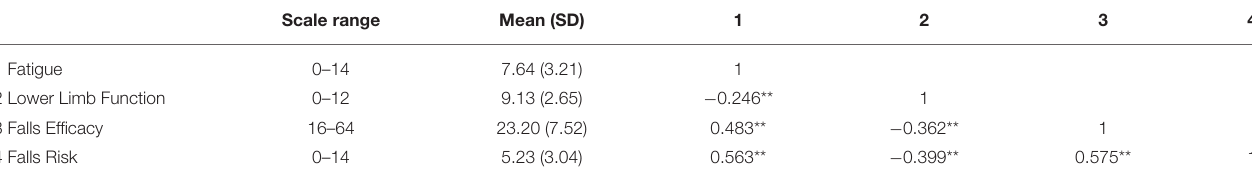
TABLE 2 | Descriptive statistics and correlation coefficients among variables in respondents ( N =